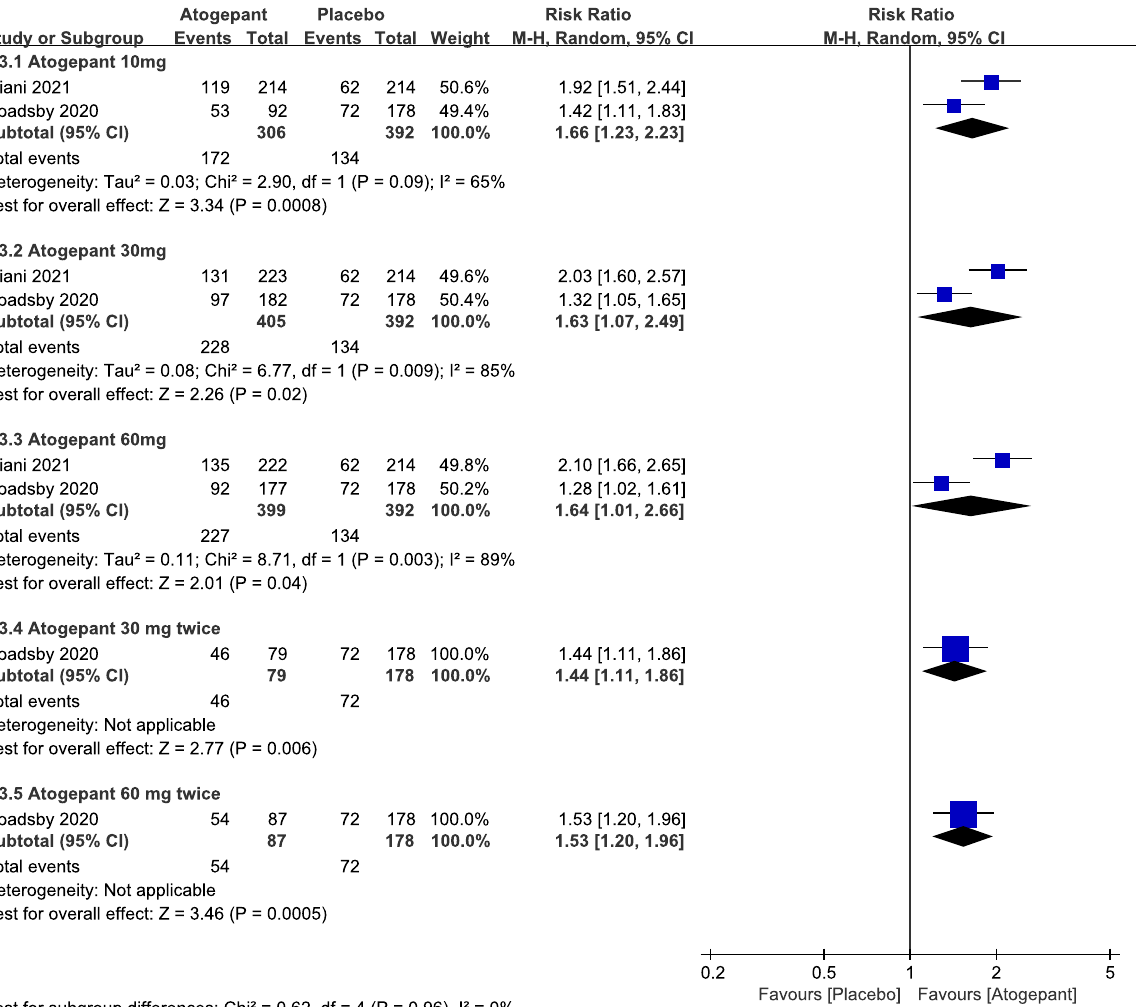
Fig. 5 The pooled RR of 50% reduction in monthly migraine days. The blue square indicates the estimated RR for each RCT. The size of blue ≥ square indicates the estimated weight of each RCT, and the extending lines indicate the estimated 95% CI of RR for each RCT. The black diamond indicates the estimated RR (95% CI) for all patients together. CI, confidence interval; RCT, randomized controlled trial; RR: risk